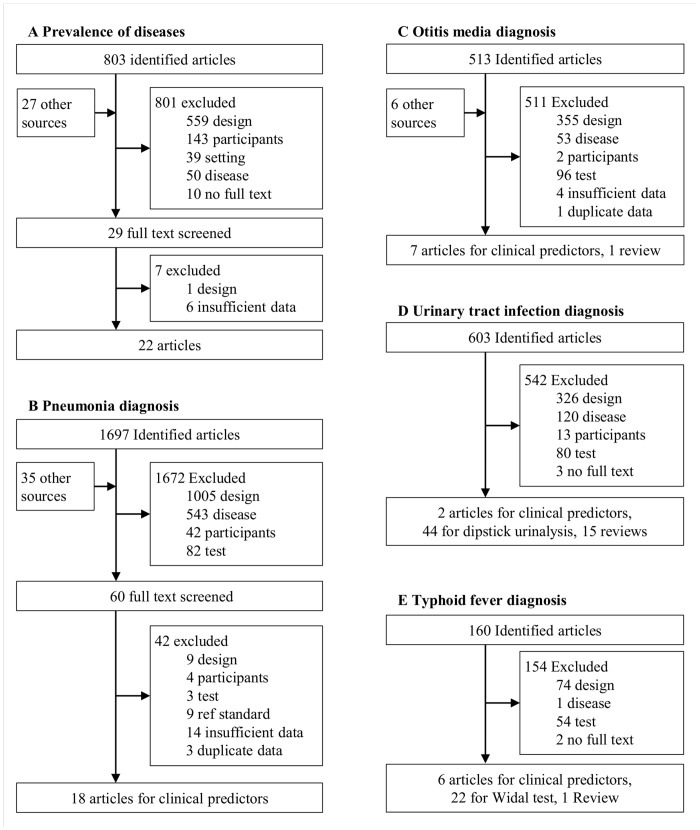
Flow diagrams of study selection process in the structured literature reviews.